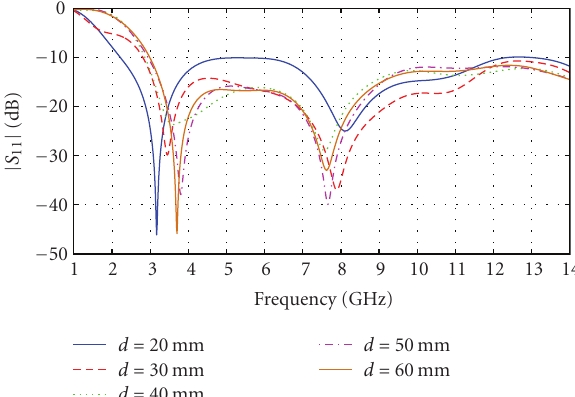
Figure 4: Simulated | S 11 | results of two-element UWB array.